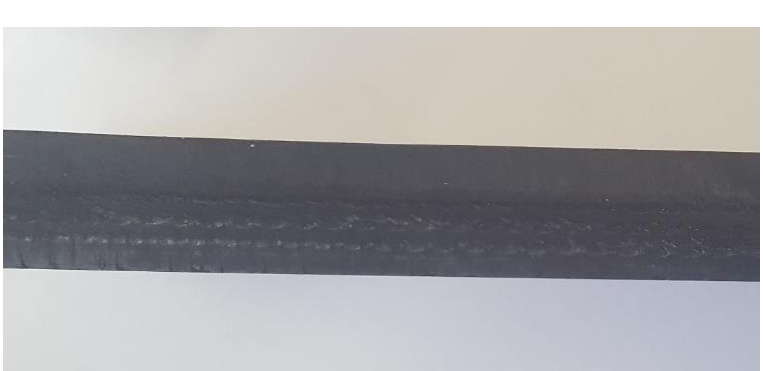
Figure 7. Conveyor belt sample with interleaved layer.